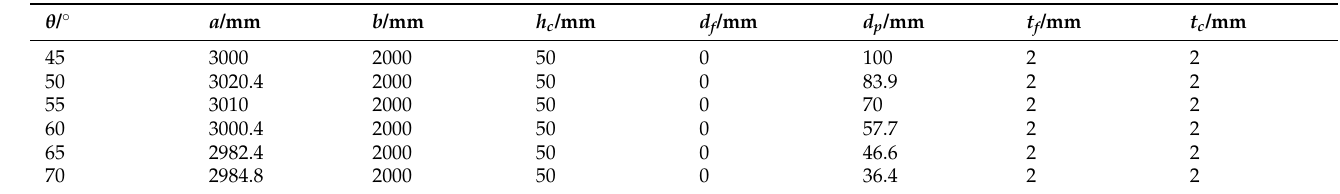
Table 11. Geometric parameters of the V-type sandwich panel with different angles.